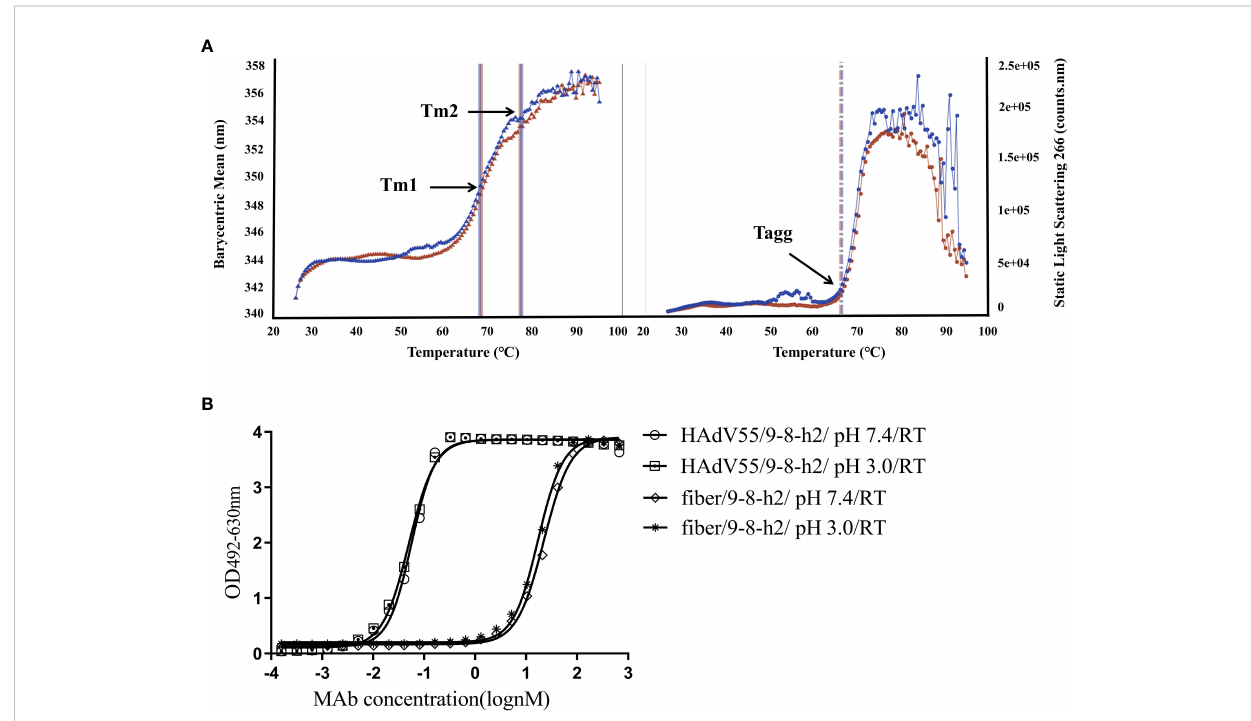
FIGURE 7 Physical properties of humanized mAb 9-8-h2. (A) Tm and Tagg with optional DLS detection of the developed characteristics of the thermostability properties of mAb 9-8-h2. The data are from two independent replicate experiments. (B) ELISA of mAb 9-8-h2 and HAdV55/ fi ber binding. MAb 9-8- h2 was incubated under different pH value (pH3 or